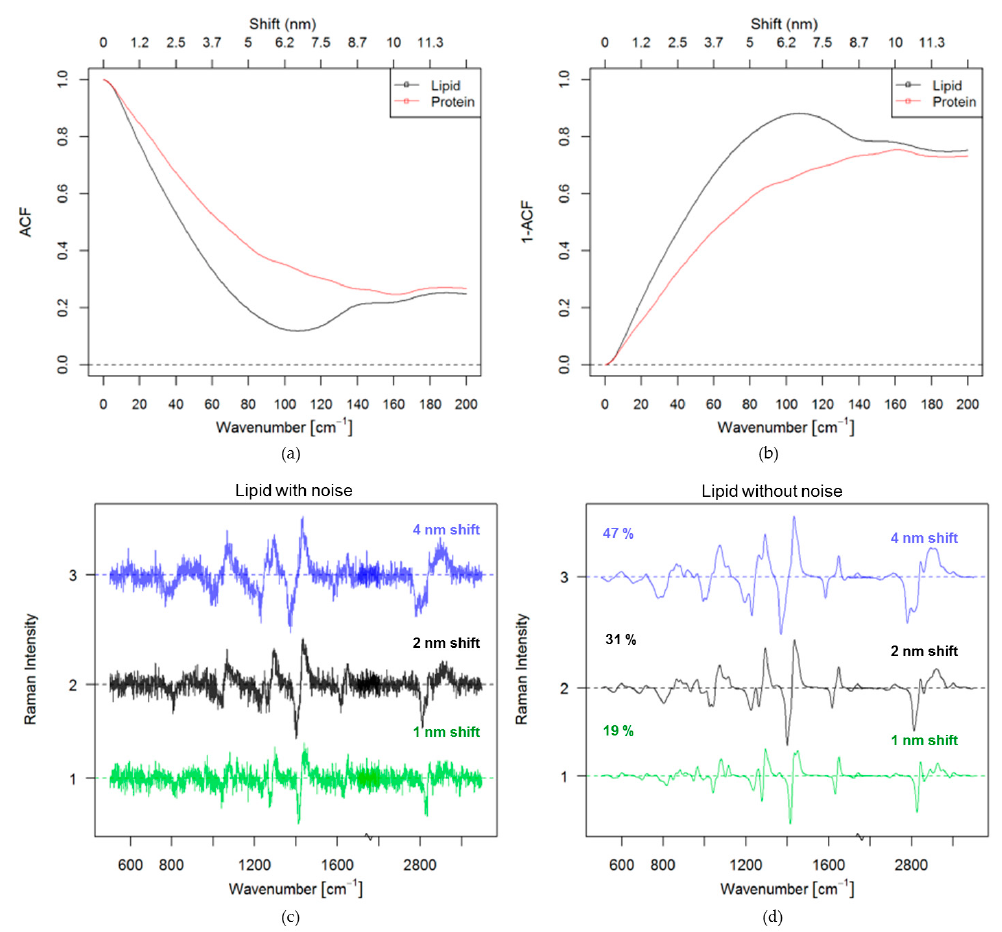
Figure 2. Optimal shift: ( a ) Estimation by using the autocorrelation function of lipid and protein spectra ( b ) Estimation by using the 1-autocorrelation function of lipid and protein spectra; ( c ) Simulation of the difference spectra of lipid at 1 nm shift (green), 2 nm shift (black) and 4 nm shift (blue) with noise, the values are the percentage values of the retained signal; ( d ) Simulation of the difference spectra of lipid at 1 nm shift (green), 2 nm shift (black) and 4 nm shift (blue) without noise. The absolute values of the difference spectra are illustrated in order to indicate how much signal is retained in the difference spectra. The same plot also shows the EMSC corrected spectra (green), and the original Raman spectra with and without noise, colored red and black, respectively. The processed SERDS signal (blue) has lower intensity than the EMSC corrected spectra (green). When